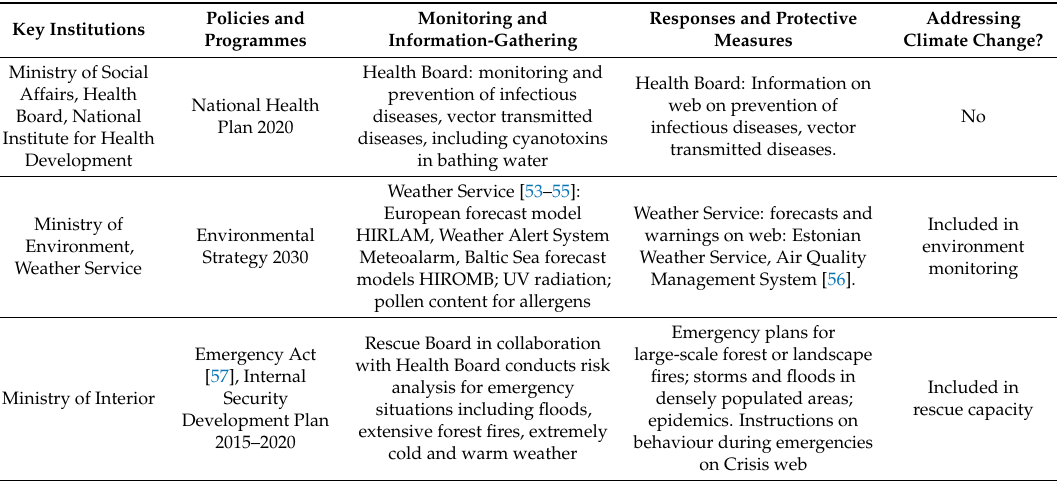
Table 1. Key institutions and responsibilities in policymaking, monitoring, and protective measures in relation to climate change